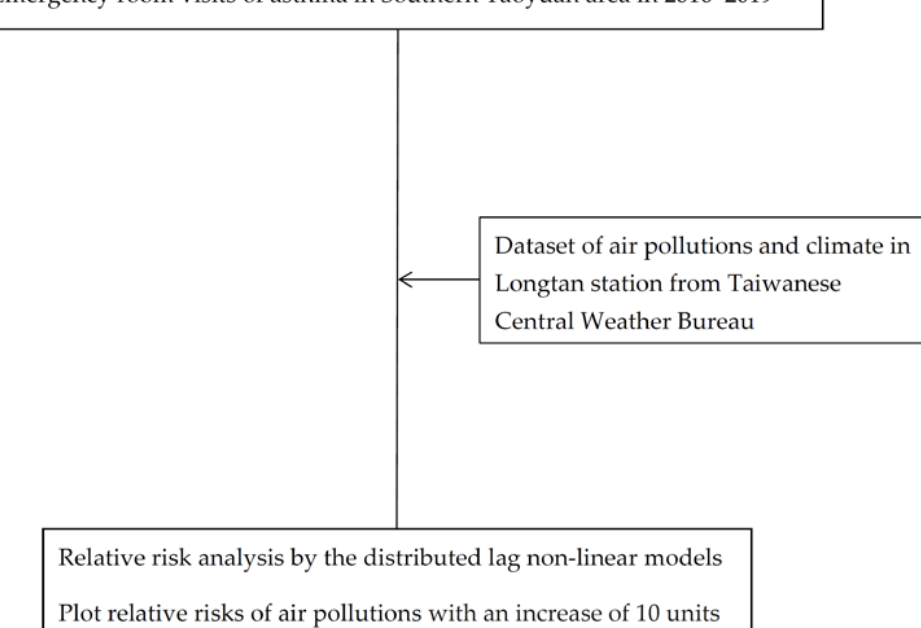
Figure 1. The flowchart in this